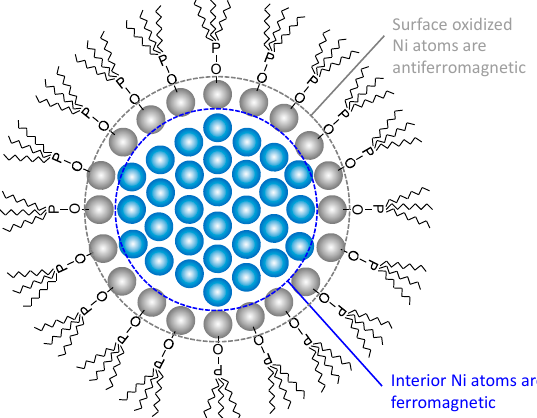
Figure 10. The supposed model of the Ni nanoparticles capped by trioctylphosphine oxides (TOPO).